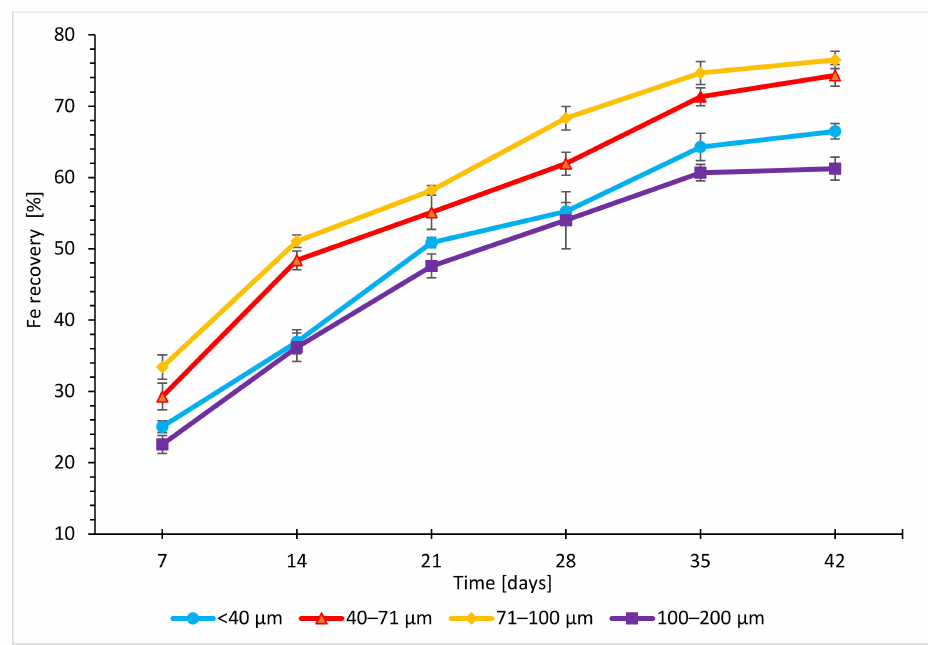
Figure 5. Influence of particle size on Fe recovery (pH 2, stirring speed 100 rpm, and 6.67% ( w / v ) pulp